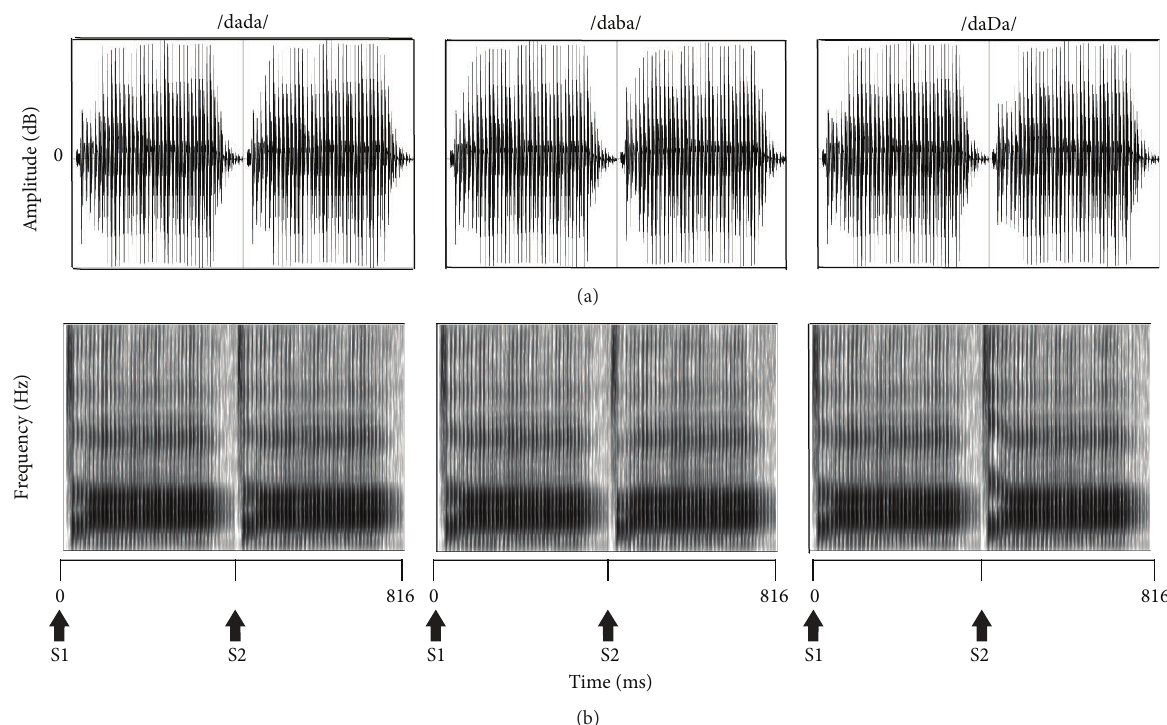
Figure 1: Stimuli used to elicit the acoustic change complex shown as waveforms in the time domain (a) and spectrograms (b). S1 and S2 indicate the time point where the first speech token /da/ and second speech tokens /da/, /ba/, and /Da/